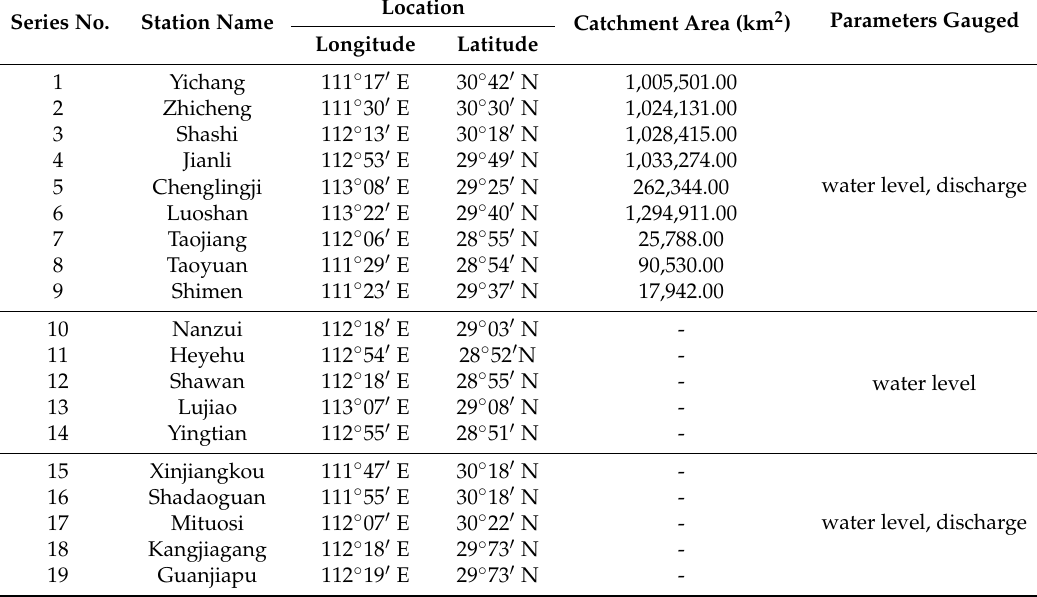
Figure 1. Location of the river ‐ lake system in the middle Yangtze River. Table 1. The detailed information of gauging stations in the river ‐ lake system. Series N o.